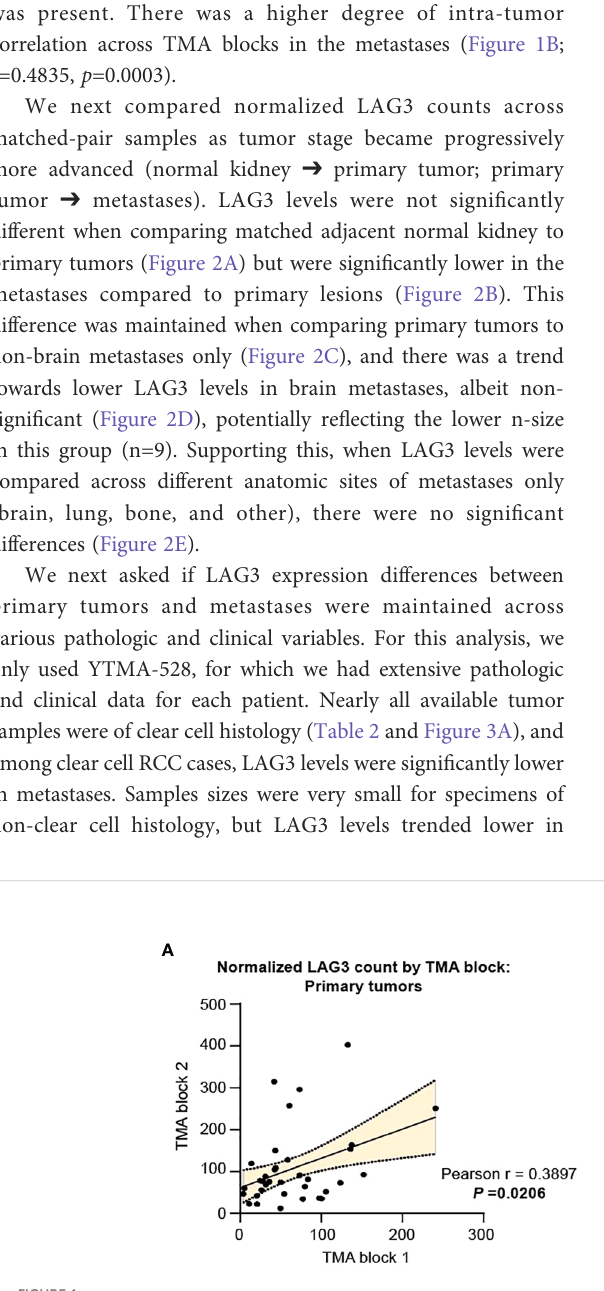
FIGURE 1 Intratumor heterogeneity in LAG3 expression is more pronounced in primary specimens compared to metastases. LAG3 expression in replicate cores from the same tumor specimen for (A) primary and (B) metastatic tumors. The linear best- fi t line is shown with the 95% con fi dence band. The Pearson correlation coef fi cient (r) and the associated p-value were calculated for each